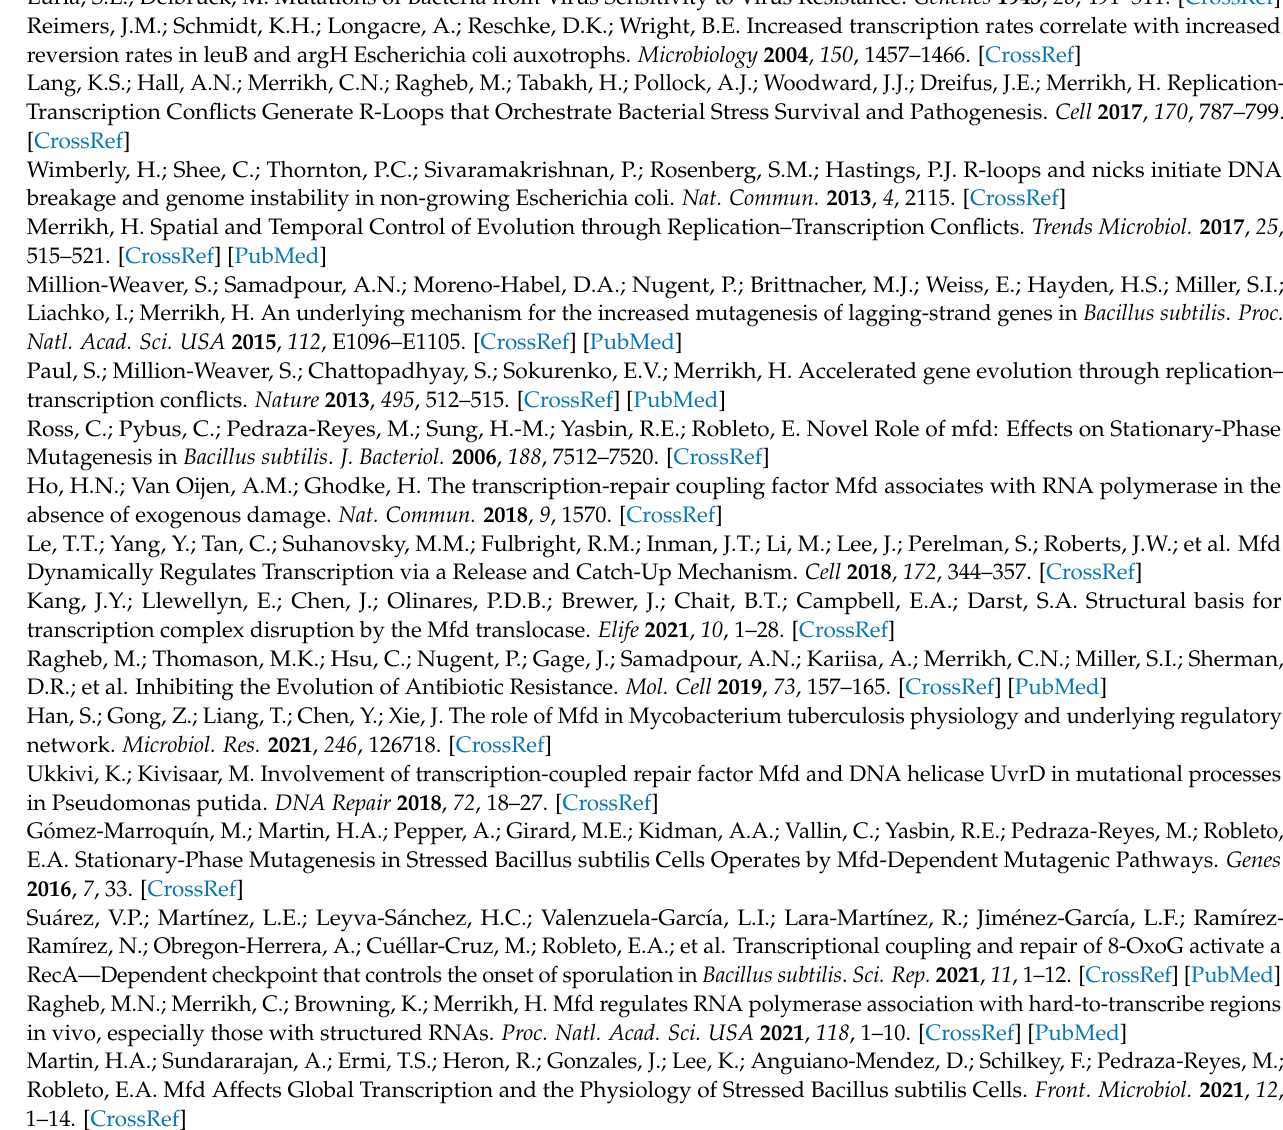
Figure S10: Modified figure from Bsucyc.org showing the cellular function of the 39 genes that contained the G4 motif used in this study. Table S1: QGRS Pattern search in argF ORF. Table S2: QGRS Pattern search in B. subtilis coding regions. Table S3: QGRS Results. Table S4: Primers used in this study. Table S5: Summary of Phenotype